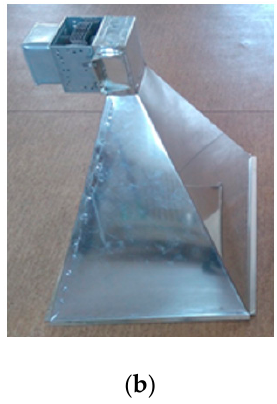
Figure 10. Emission diagram for an antenna with a gain of 17 dBi. ( a ) Matlab; ( b ) Antenna Magus software.